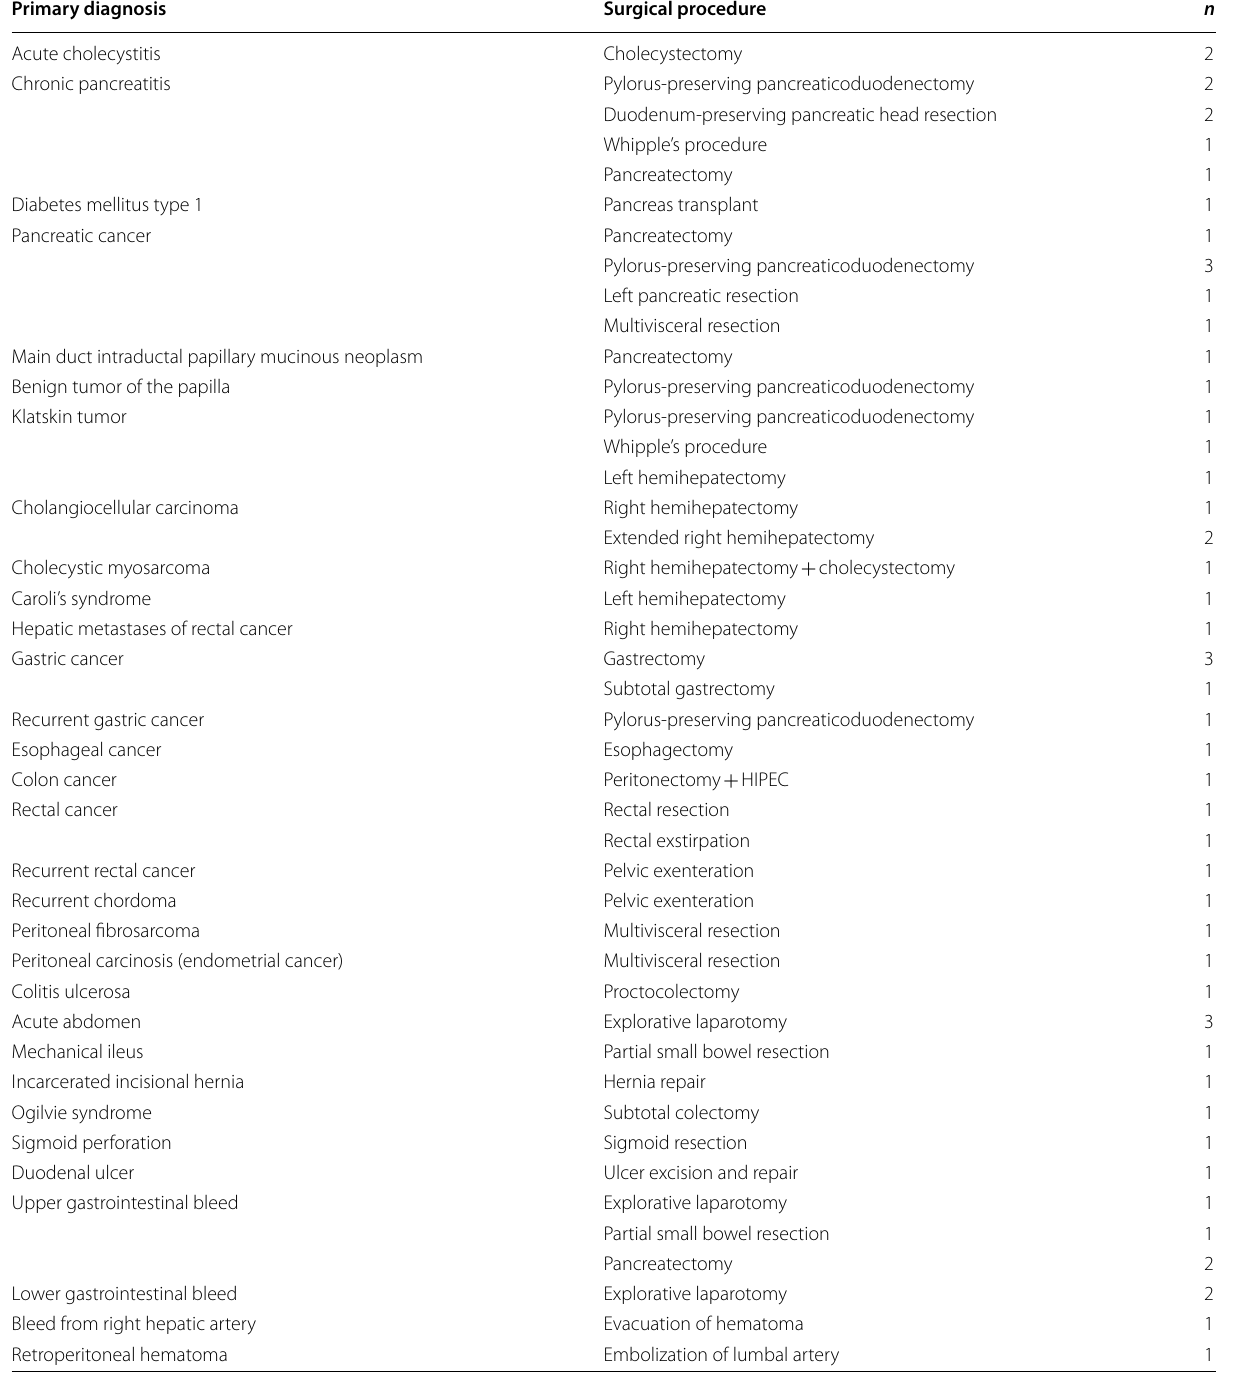
Table 1 Primary diagnoses and surgical procedures of our study population Primary diagnosis Surgical procedure n Acute cholecystitis Chronic